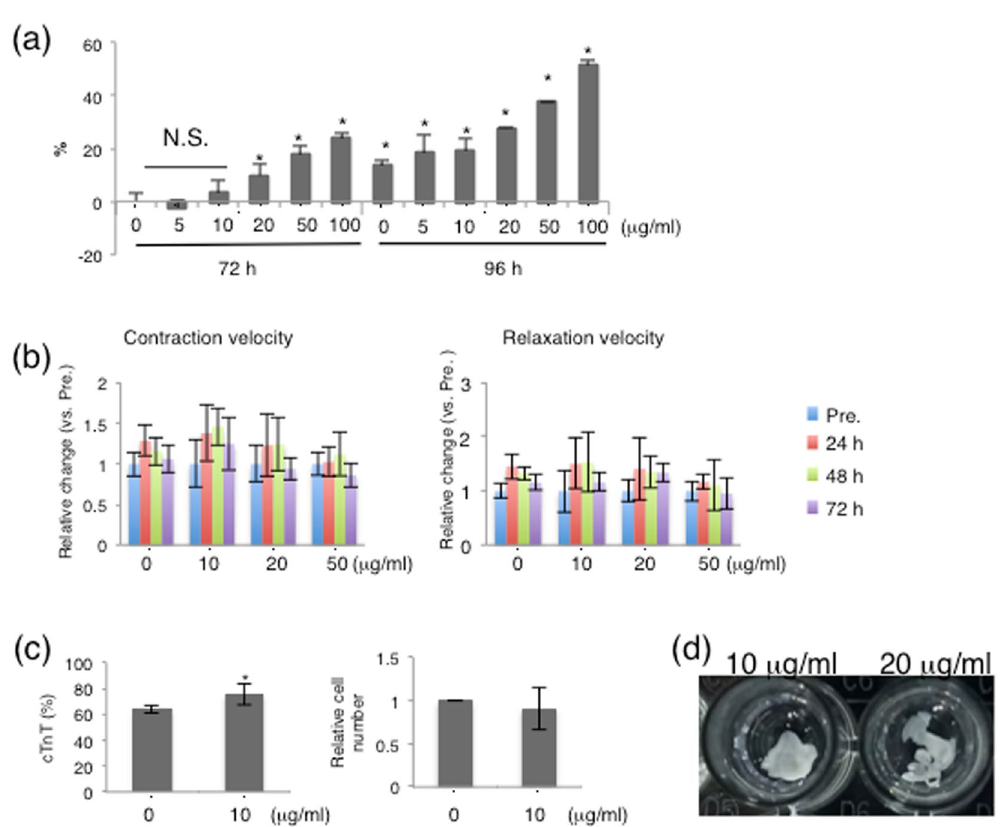
Figure 6. Cytotoxicity of brentuximab vedotin to hiPSC-derived CMs ( a ) Cytotoxicity of brentuximab vedotin in hiPSC-derived CMs was assessed by LDH assay. Y-axis indicates relative cytotoxicity compared with non-treated hiPSC-derived CMs for 72 h. Experiments were repeated at least thrice independently. * p < 0.01 vs. 72 h, 0 μ g/ml. ( b ) Contraction and relaxation velocity of hiPSC-derived CMs was assessed by motion analyser system. Y-axis indicates relative change compared to pre-treatment hiPSC-derived CMs. ( c ) The percentage cTnT-expressing hiPSC-derived CMs and the relative number of hiPSC-derived CMs were assessed after they were cultured in normal medium for a week. * p < 0.05 vs. 72 h, 0 μ g/ml. ( d ) Effect of brentuximab vedotin on cell sheet formation. At 72 h after starting treatment of hiPSC-derived CMs with brentuximab vedotin in a temperature-responsive plate, monolayered cell sheets were fabricated using cells treated with brentuximab vedotin at 10 μ g/ml (left) and 20 μ g/ml (right). Panels are representative macroscopic images of monolayered cell